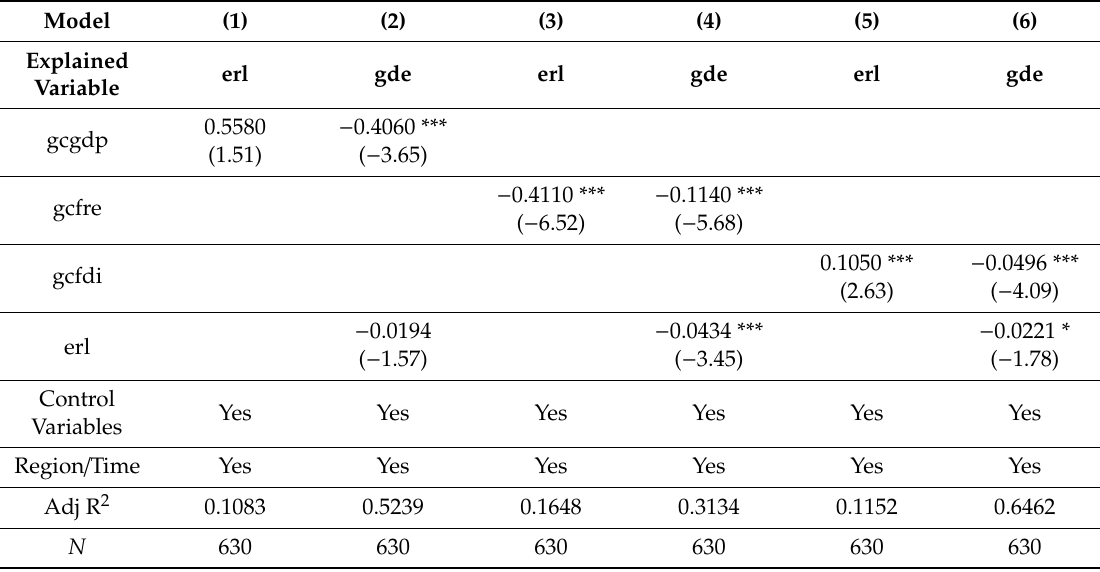
Table 7. Mediating e ff ect regression